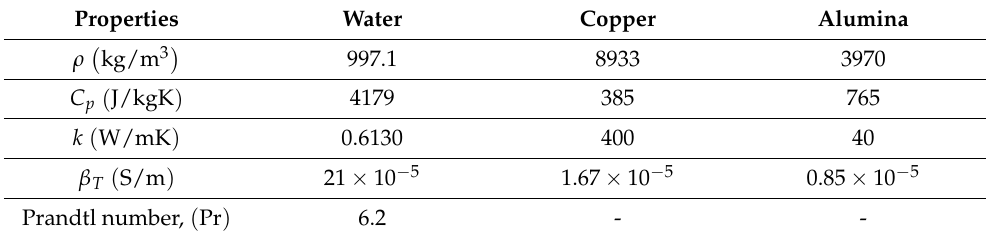
Table 2. Thermophysical properties for H 2 O, Al 2 O 3 , and